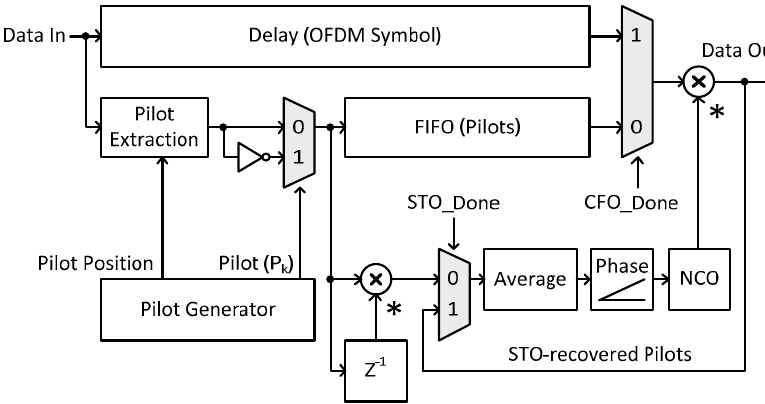
Figure 13. Block diagram of residual STO and CFO synchronization.